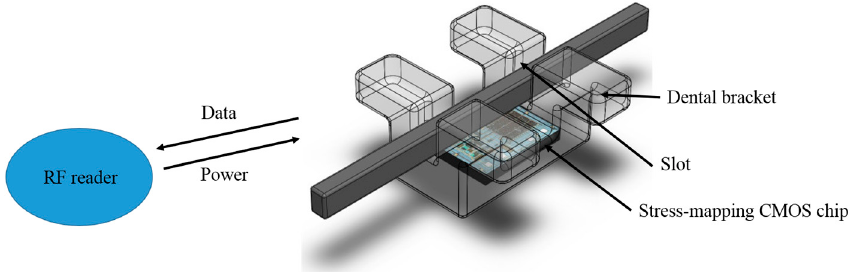
Figure 1 . Dental bracket with stress-mapping CMOS chip for telemetric stress measurement during orthodontic therapy (adapted from